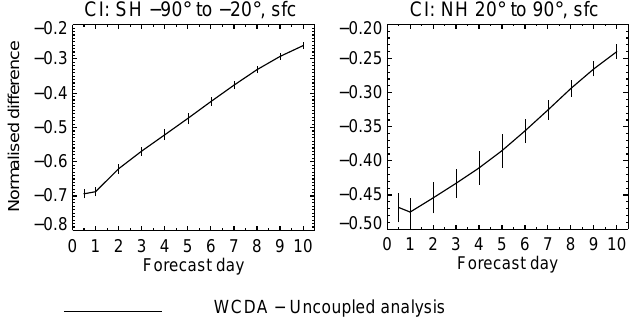
Figure A1. Area-averaged diagram of the normalised difference in RMSE between WCDA and the control for sea ice concentration in the southern hemisphere ( left ), tropics ( centre ) and northern hemisphere ( right ) for forecasts at lead times of up to 10 days.